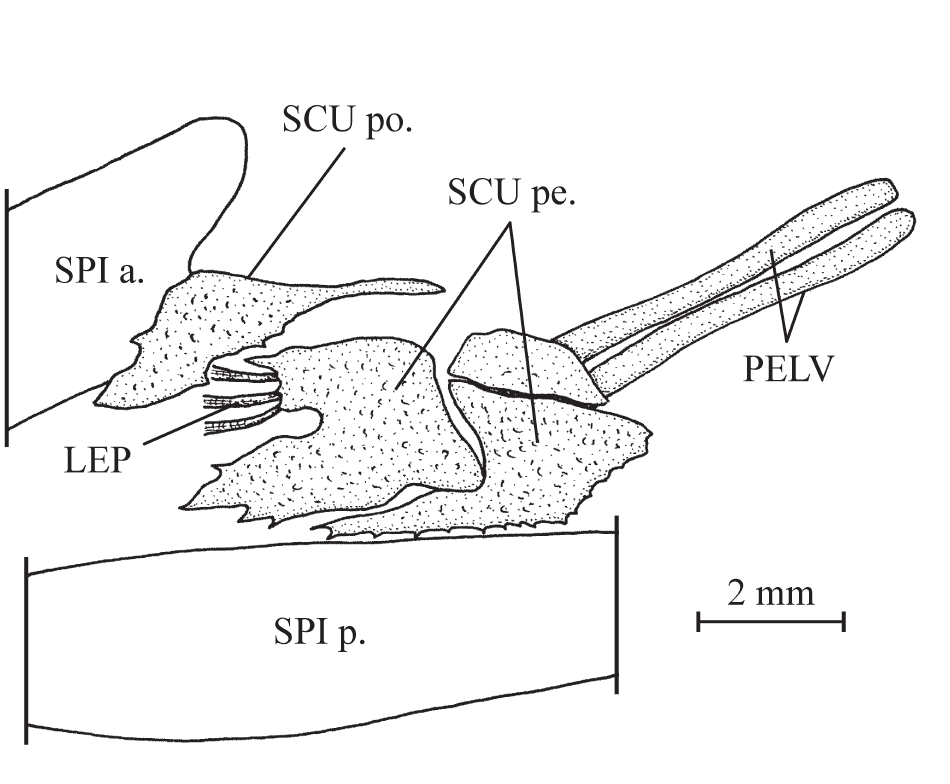
Fig. 5. Gladiopycnodus karami gen. et sp. nov. The pelvic girdle as seen on the photo of a specimen in a private